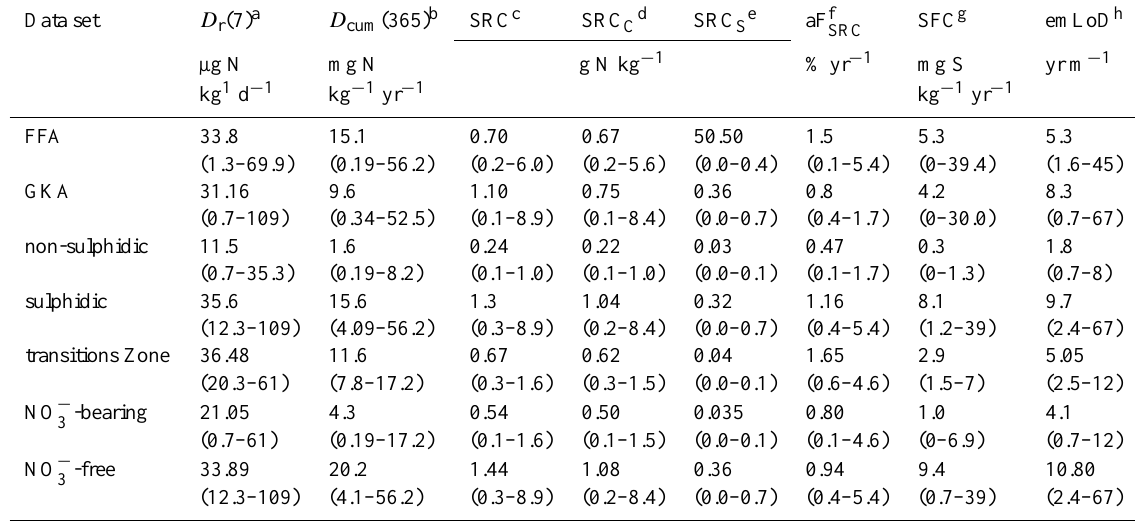
Table 2. Initial denitrification rates, long-term denitrification capacity, stock of reduced compounds, sulphate formation capacity and esti- mated minimal lifetime of denitrification (medians with ranges in